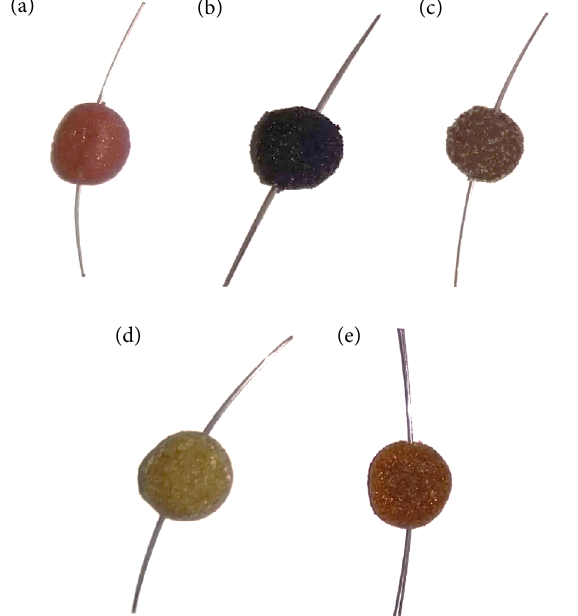
Figure 1. Pyrotechnic star with (a) Red iron oxide, (b) Activated carbon (c) Magnesium (d) Aluminium and (e)